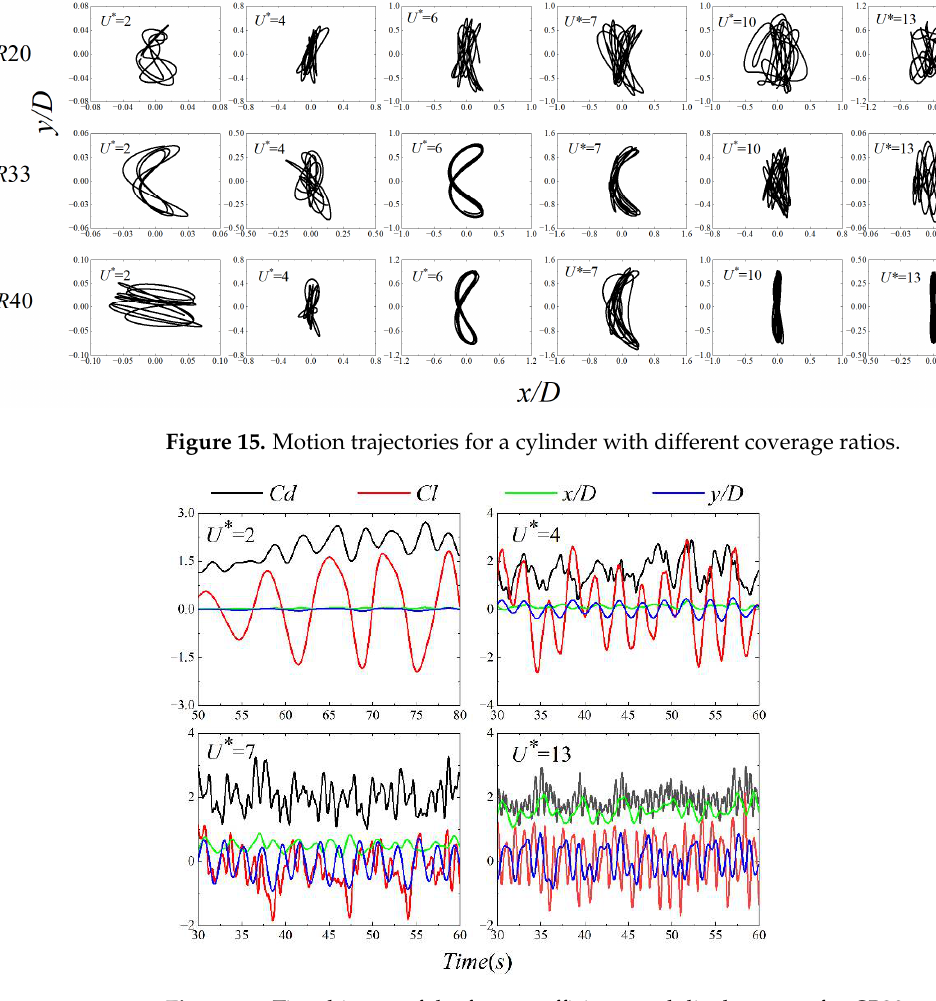
Figure 16. Time history of the force coefficients and displacement for CR 20.